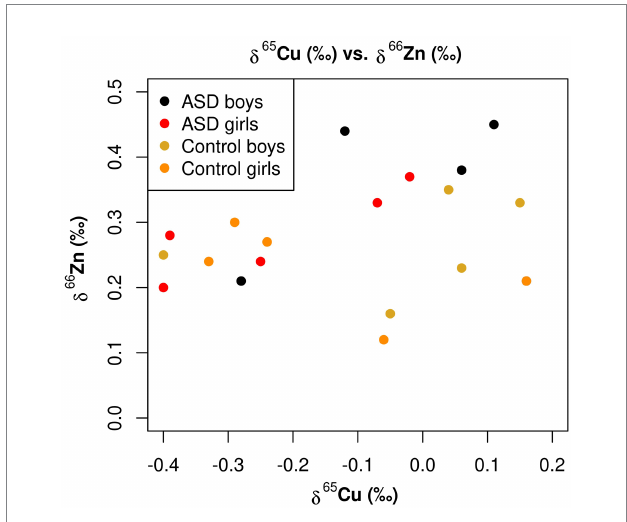
FIGURE 5 Scatterplot for the δ 65 Cu (‰) of bulk serum and the δ 66 Zn (‰) of bulk serum for the ASD and control populations.